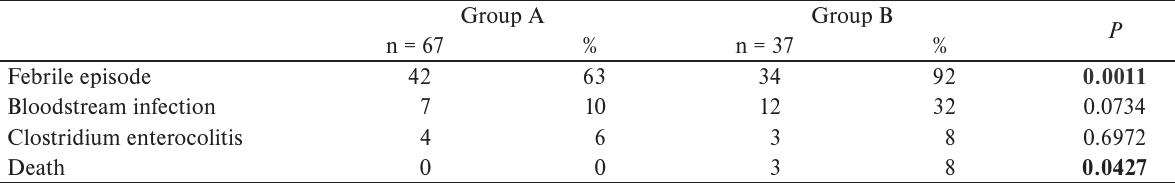
Table 5. Overall incidence of fever, BSI, Clostridium colitis and